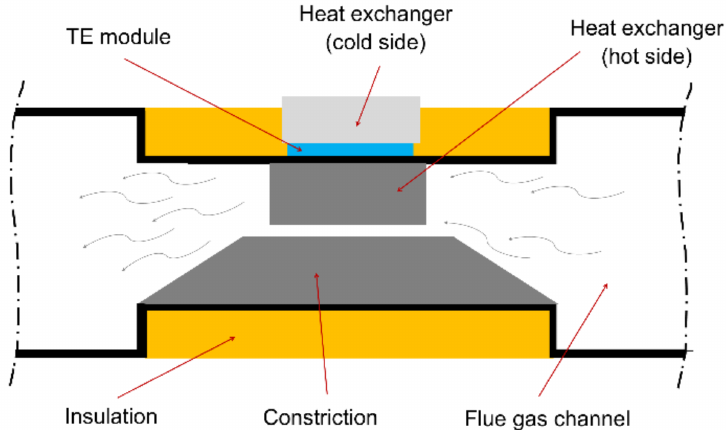
Figure 7. The simplified scheme of the initial version of the thermoelectric generator dedicated to installation in the flue gas channel (TEG No.